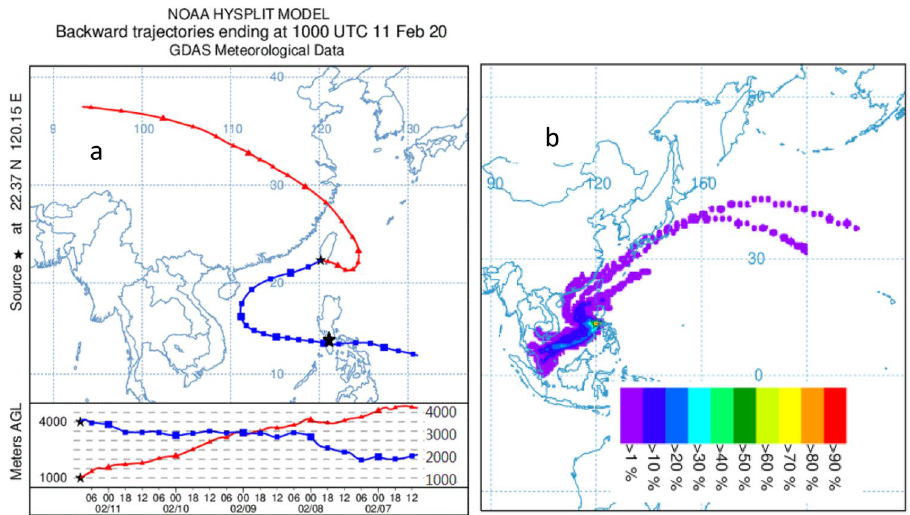
Figure 2. ( a ) Five-day back-trajectories for aerosols at 1 km and 4 km layer, both were observed by lidar at Kaohsiung. The 4 km layer (blue) can be trace to Taal region 3 days ago on Feb. 8 at 2000 m while the 1 km layer (red) is traced to northwestern China from upper air. ( b ) forward trajectories from Taal region starting Feb.8 (based on backward study in a ) for all possible transport paths in the next 5 days. The results show a small part of aerosols may move to north in KS while the majority went to Southeast Asia. Figures are plotted using HYSPLIT Trajectory Model provided by ARL NOAA 21,22